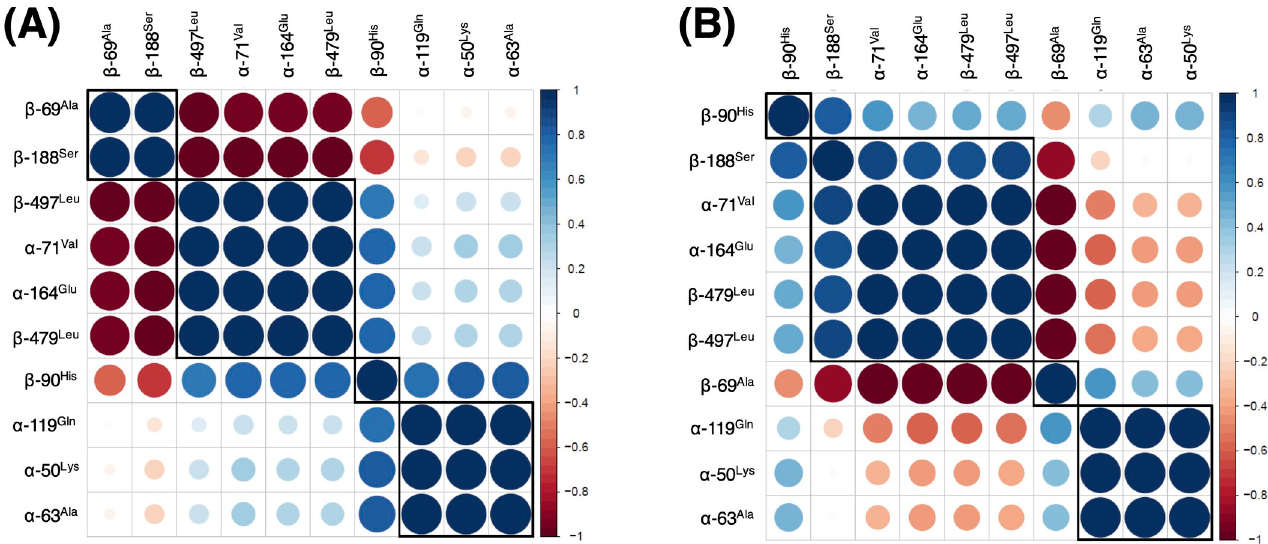
Fig 9. Correlation patterns of protein dynamics in (A) free MoFe protein and (B) MoFe protein in presence of ATP-bound Fe protein based on HDX measurements recorded after 1h of the deuterium exchange. Red and blue circles correspond to negative and positive correlations, respectively. An empty spot in the matrix (or white circle) signifies lack of any correlation. Size of the circle represents significance of the results: the larger the circle the more significant the correlation. Squares are drawn to highlight clusters with similar correlation patterns.